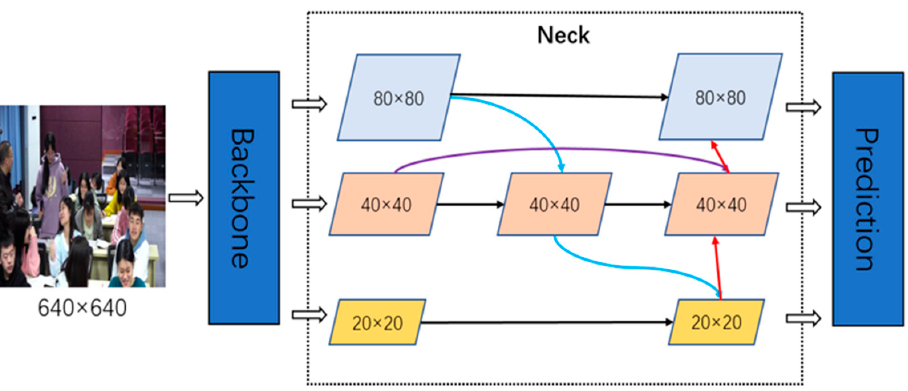
Figure 5. BiFPN feature fusion structure in this paper.